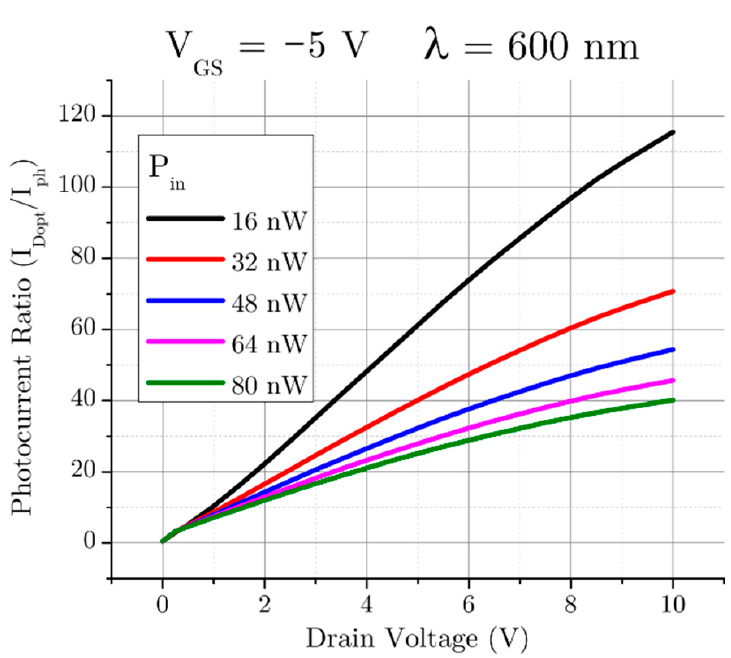
Figure 12. Results of simulation for photocurrent gain in the integrated photodetector proposed in Figure 11.